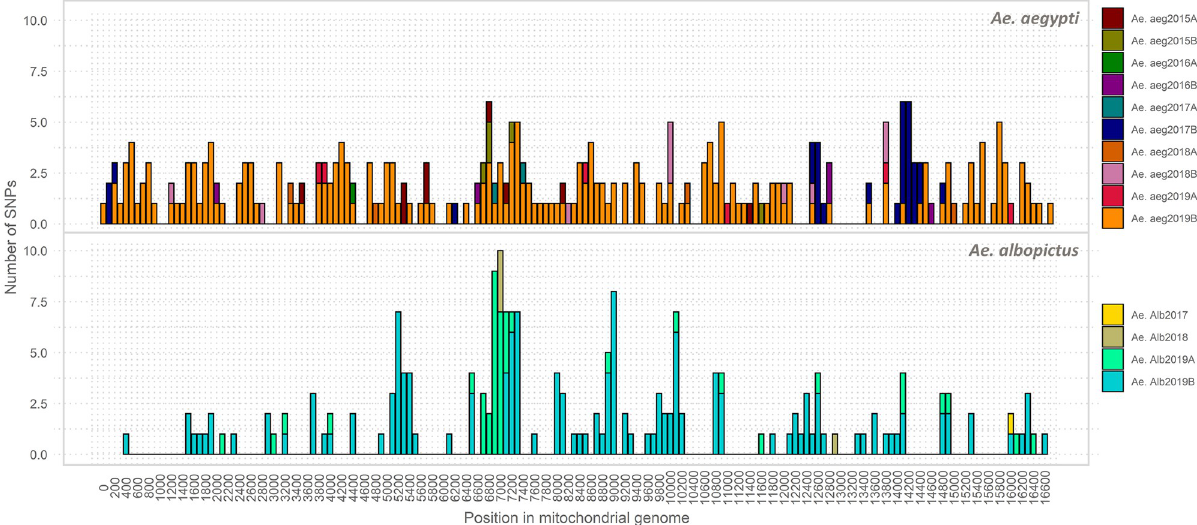
Fig 6. Mitochondrial SNP density per site in Ae . aegypti and Ae . albopictus samples collected between 2015 and 2019 in Medellı´n, Colombia.